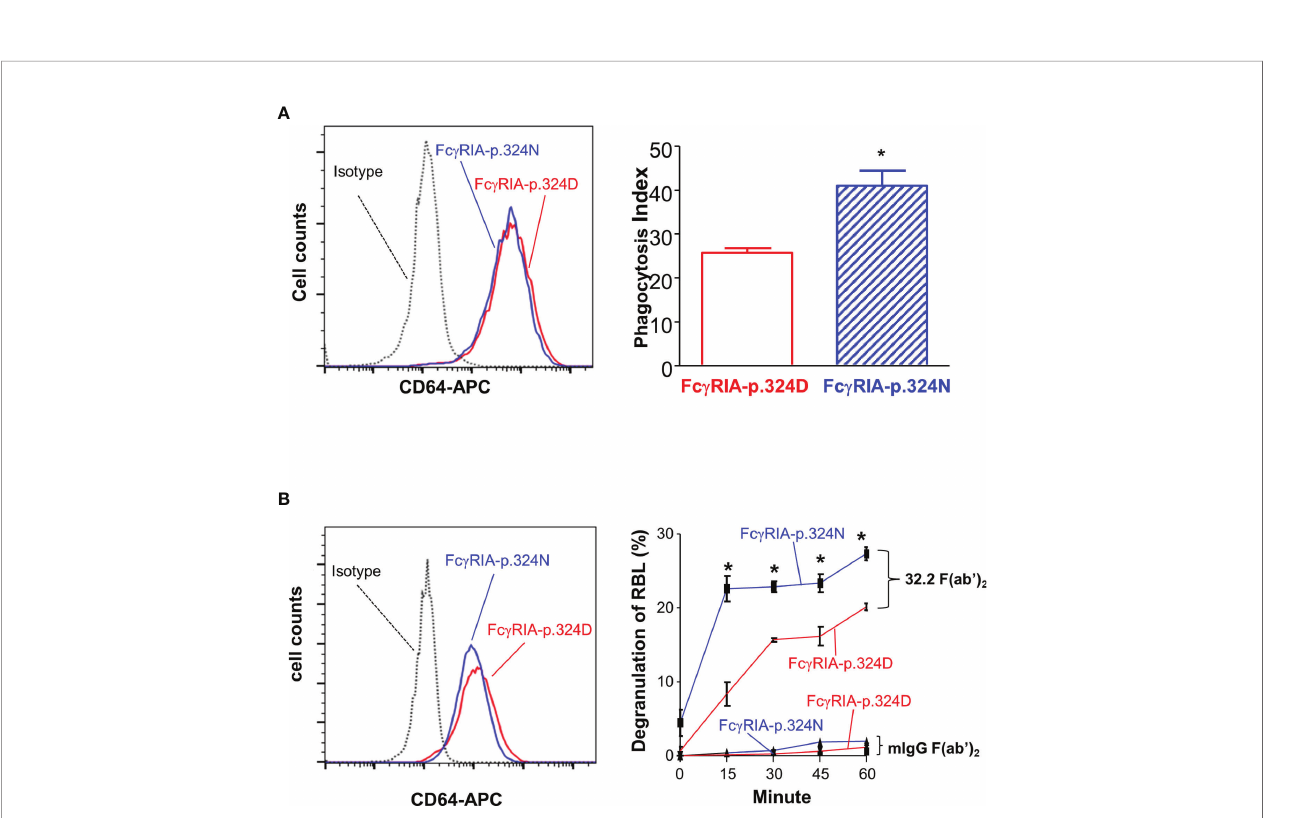
FIGURE 4 | FCGR1A SNV rs1050204 (c.970G>A or p.D324N) alleles affect CD64-mediated phagocytosis and degranulation. (A) Effect of the SNV rs1050204 (Fc g RIA-p.D324N) on Fc g RIA-mediated phagocytosis. P388D1 cell lines expressed equivalent levels of Fc g RIA-p.324D (rs1050204G) and Fc g RIA-p.324N (rs1050204A) (left panel). Fc g RIA-p.324N mediated signi fi cantly higher levels of phagocytosis (*Student ’ s t-test P = 0.0056, n = 4). (B) Effect of the SNV rs1050204 (p.D324N) on Fc g RIA-mediated degranulation. Stably transfected and RBL cell lines express Fc g RIA-p.324D (rs1050204G) and Fc g RIA-p.324N (rs1050204A) alleles at comparable levels. Fc g RIA-mediated degranulation induced by anti-CD64 mAb 32,2 F(ab ’ ) 2 crosslinking was signi fi cantly higher in the RBL cells with Fc g RIA- p.324N allele than those with Fc g RIA-p.324D (*Student ’ s t-test, P < 0.01, n = 4). No degranulation was induced by the irrelevant mIgG F(ab ’ ) 2 in the stable RBL cells expressing either p.324D and p.324N